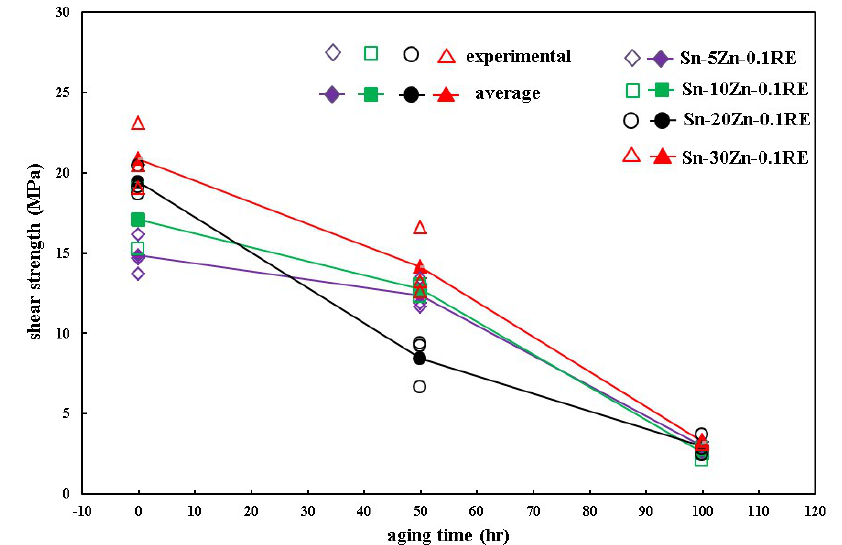
Figure 8. The shear strengths of the AZ31 magnesium alloy/6061 aluminum alloy joints soldered with Sn-xZn-0.1RE (x = 5, 10, 20, and 30) filler metals after aging at 150 °C for various times.